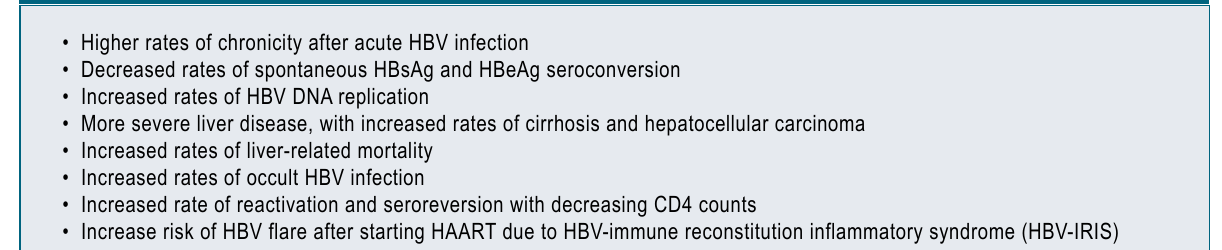
TABLE I. INFLUENCE OF HIV ON THE COURSE OF HEPATITIS B VIRUS INFECTION